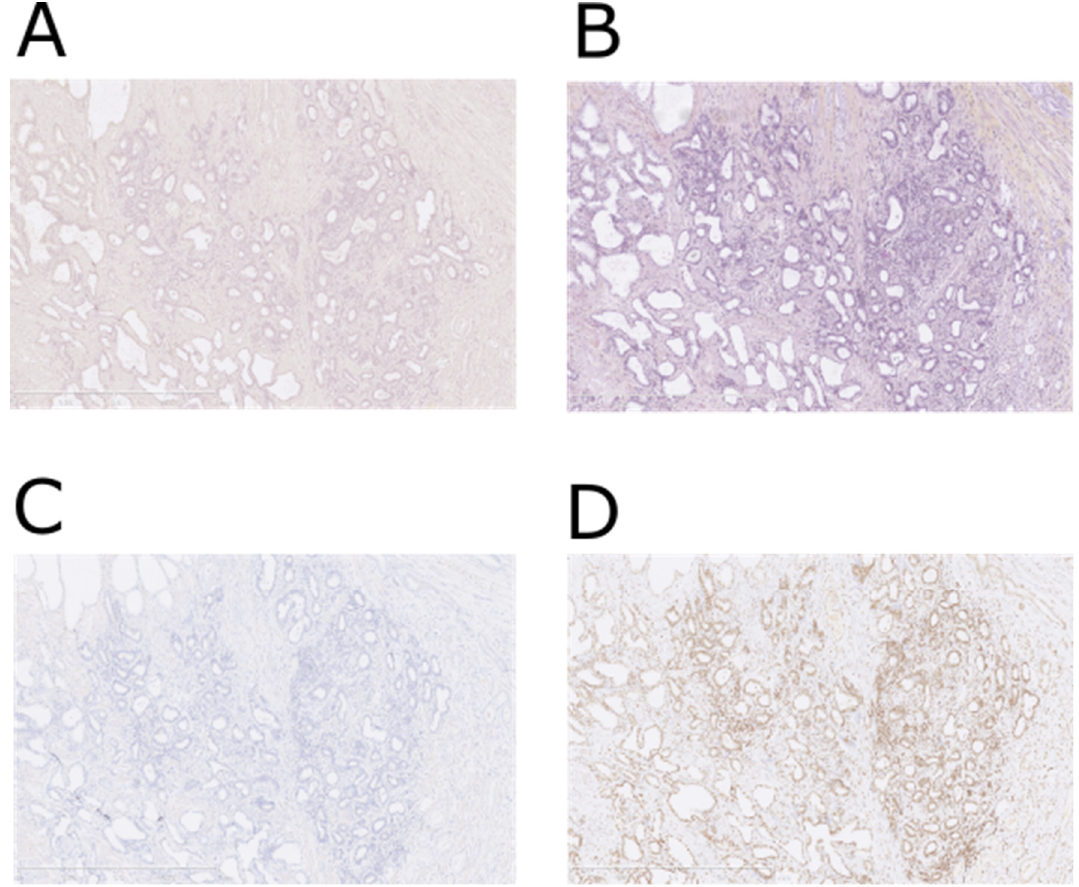
Figure 1. Example of a prostatic ISUP-2 sample (HES staining in ( A )) negative for PSMA ( B ) and GRP-R ( C ) immunohistochemistry, but with positive staining for NTS 1 immunochemistry ( D ). Images were taken at 10× magni fi cation.